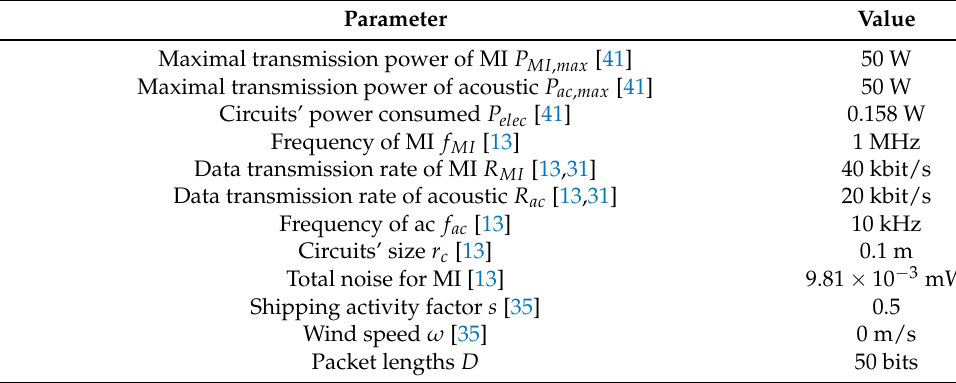
Table 2. Simulation parameters.